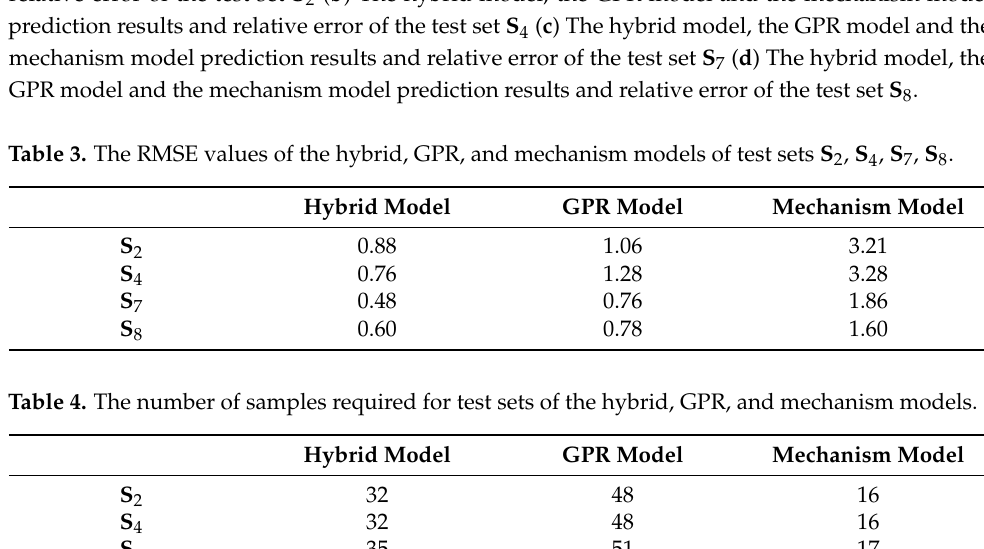
Table 3. The RMSE values of the hybrid, GPR, and mechanism models of test sets .